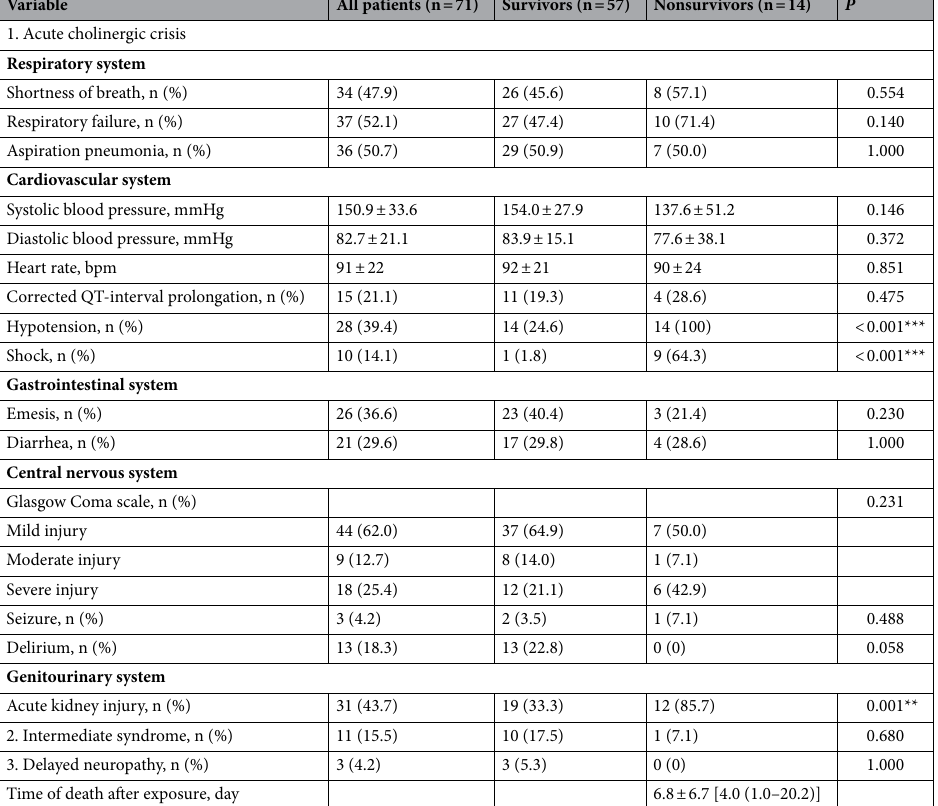
Table 3. Clinical findings of elderly patients with organophosphate poisoning, stratified according to status at discharge as survivors or nonsurvivors (n = 71). Categorical variables were presented as numbers with percentages in brackets, while continuous variables were presented as the means and standard deviations. Time of death after exposure was presented as means and standard deviations as well as median and range. ** P < 0.01, *** P <